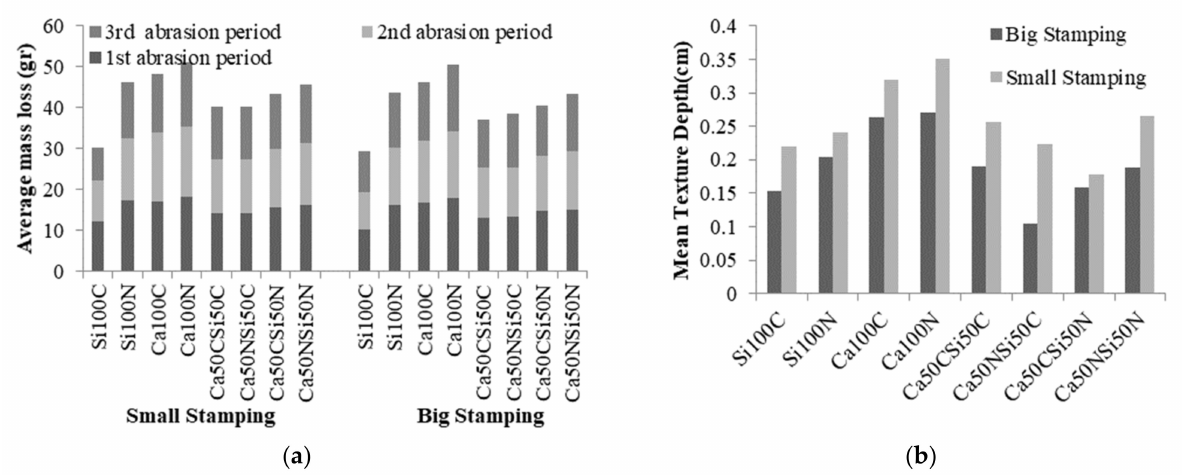
Figure 11. Abrasion resistance in form of average mass loss and MTD of stamping macro-textures versus different mix proportions.